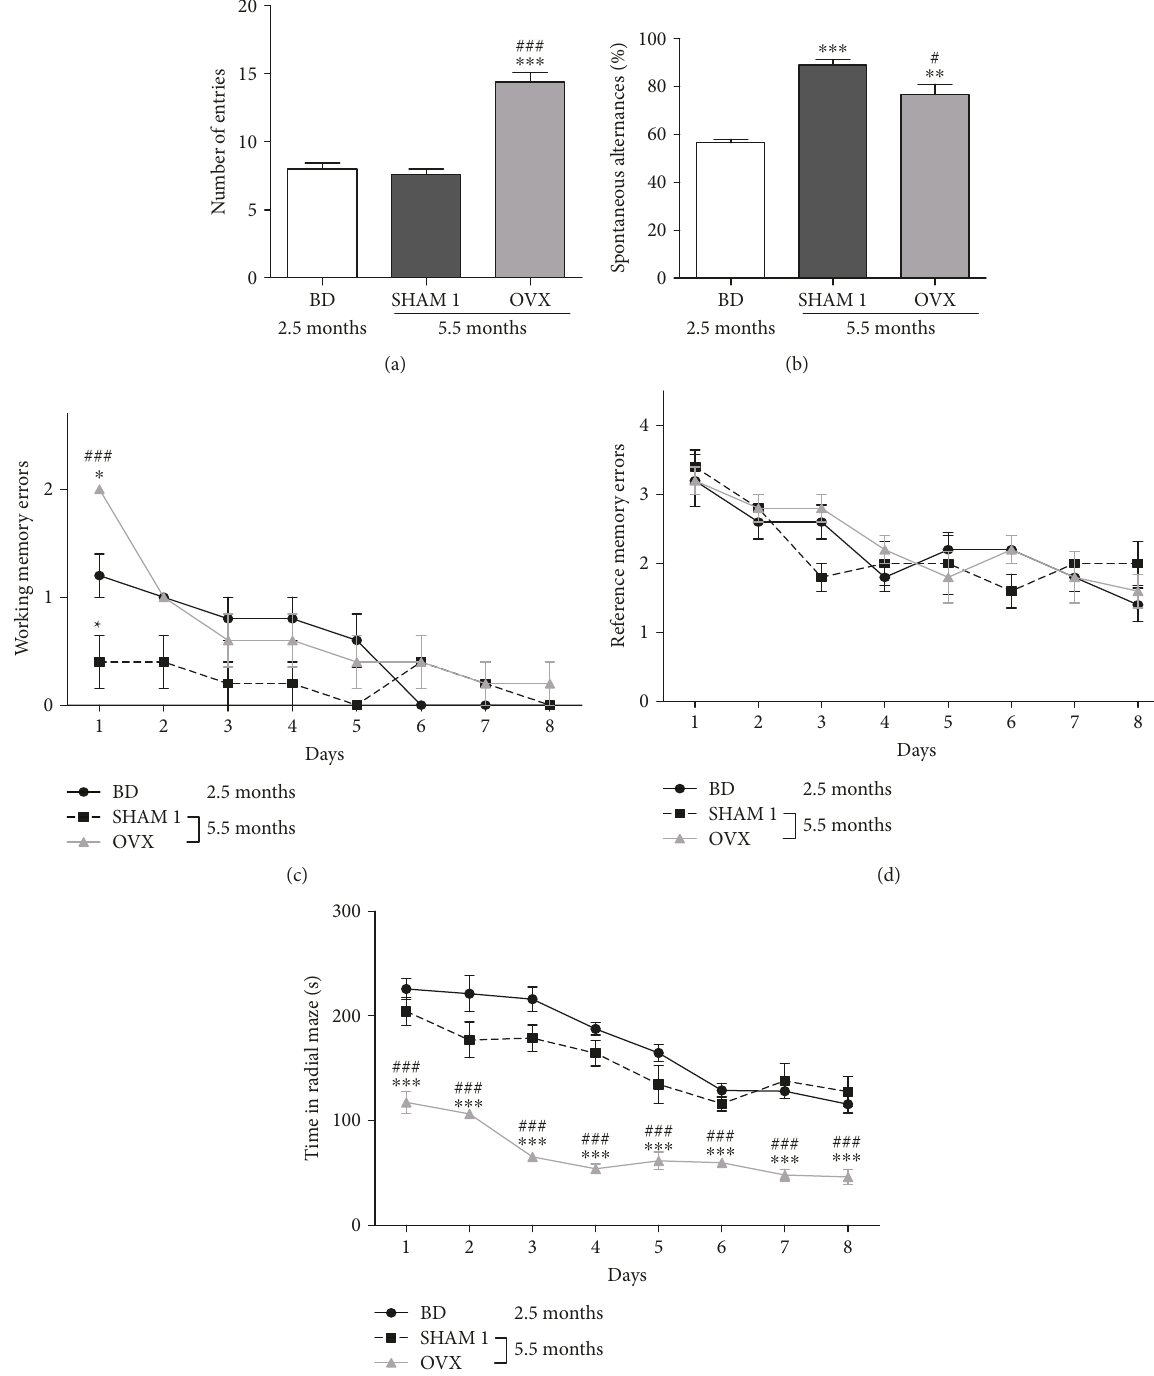
Figure 2: E ff ects of age and ovariectomy on number of entries (a), spontaneous alternances (b), working memory (c) and spatial reference memory (d) errors, and the time past in radial maze (e). OVX =ovariectomized rat aged 5.5 months; BD=nonovariectomized rats aged 2.5 months which served as basic data; SHAM 1=nonovariectomized rats aged 5.5 months. ∗ p < 0 05 , ∗∗ p < 0 01 , and ∗∗∗ p < 0 001 as compared to control BD. # p < 0 05 and ### p < 0 001 as compared to the NOR